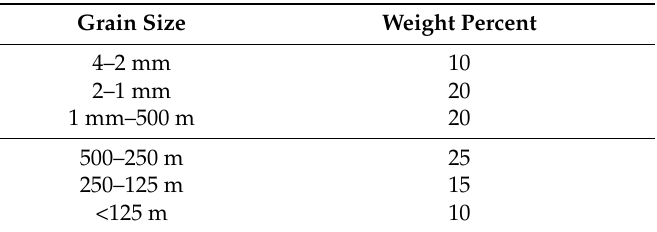
Table 3. Grain size gradation of sands subjected to leaching tests.